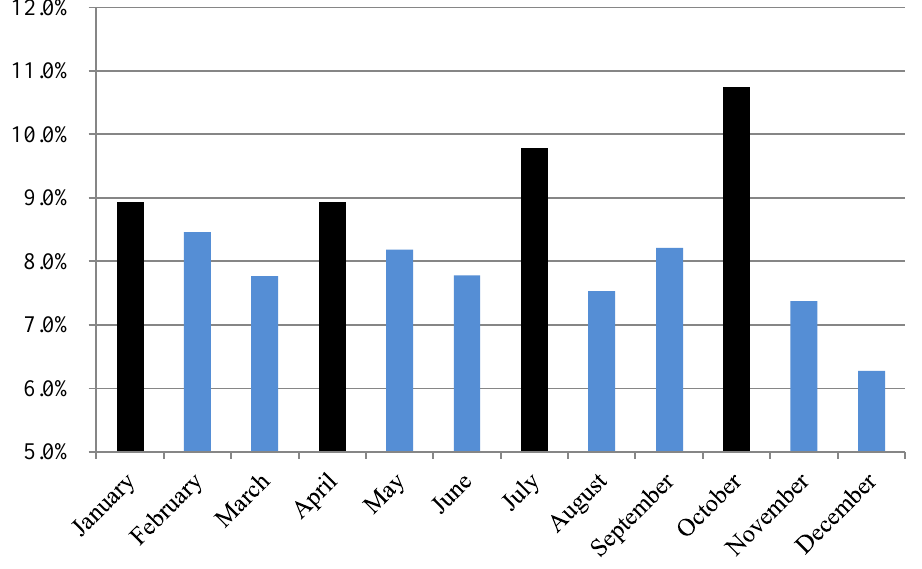
Figure 3. Percentage of news stories out of total by month, from 1 January 2003 to 30 September 2012. The occurrence of news items aggregated by month has a cyclical pattern.